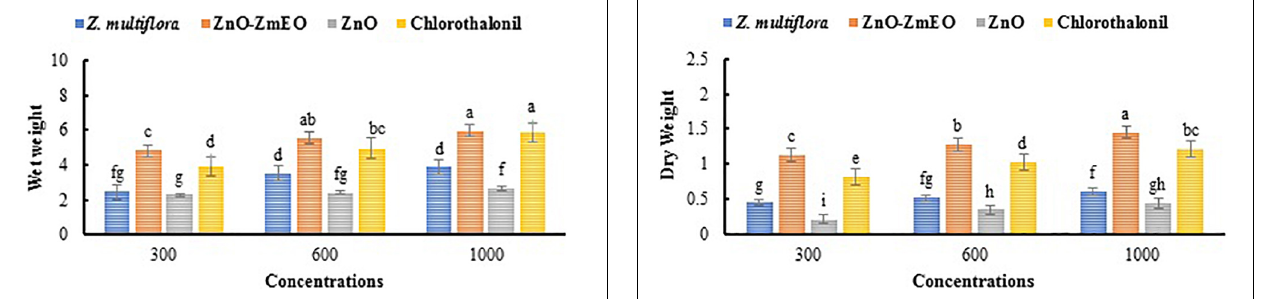
FIGURE 7 | Comparison of mean wet weight of tomato plants treated by different concentrations of the ZnO, pure Z. multiflora EO, ZnO-ZmEO, and chlorothalonil.